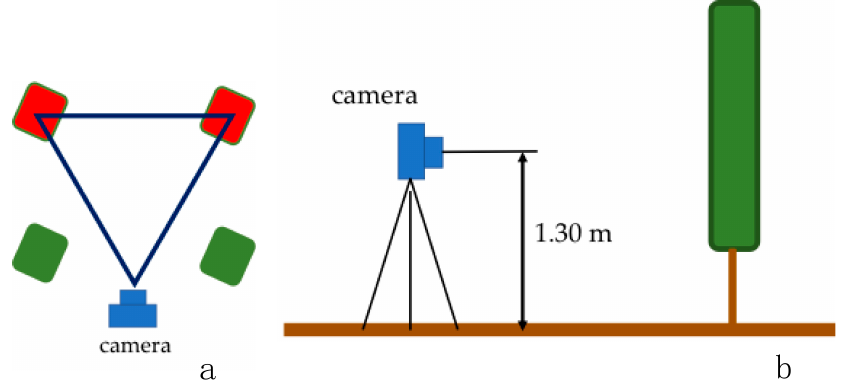
Figure 2. ( a ) Camera position in relation to the considered pair of plants. ( b ) Camera position in relation to the